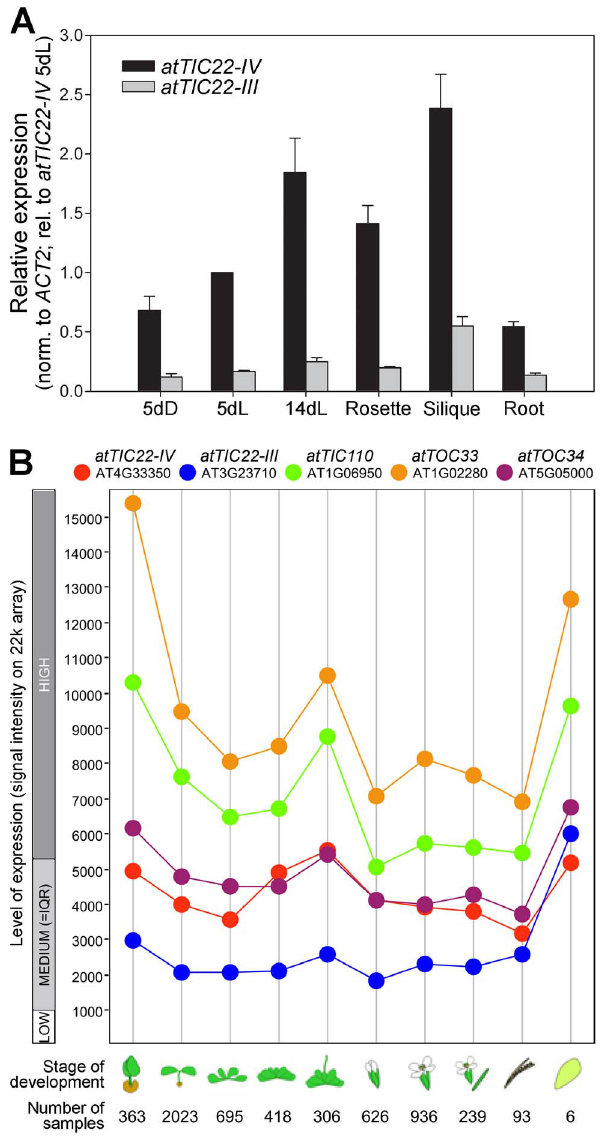
Figure 2. Expression of the Tic22 genes in different tissues and at different developmental stages. A. Quantitative RT-PCR analysis of total-RNA from whole seedlings grown for five days in the dark (5dD), or five and 14 days in the light (5dL and 14dL, respectively), as well as from three different tissues of mature plants (rosette leaves, siliques, and roots). RNA samples were representative of , 10–30 seedlings (5dD, 5dL and 14dL), or 5–25 mature plants (rosettes, siliques and roots). Tic22 data were normalized relative to the control gene, ACTIN2 (At3g18780), and then expressed relative to the atTIC22-IV 5dL value. Data shown are means ( 6 SE) derived from three biological replicates. [29,60]. Presented data were prepared using the Development representation in scatter-plot format. Data from all high-quality ATH1 (22 k) arrays were analysed; this amounted to a total of 7392 samples. Values shown are means. The total number of samples used to derive each data point shown is indicated. Typical ranges of low, medium, and high expression for the array type are shown; medium is defined as the interquartile range (IQR). Stages of development are defined as follows, from left to right: germinating seed, seedling, young rosette, developed rosette, bolting, young flower, developed flower, flowers and siliques, mature siliques, and senescence. Data representations were exported from Genevestigator in portable document format, and then